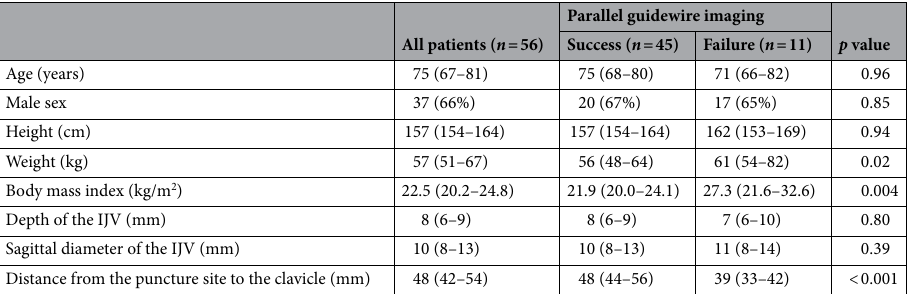
Table 1. Comparison of the characteristics of patients in whom parallel guidewire imaging succeeded or failed. Data are presented as median (interquartile) or number (proportion). IJV internal jugular vein.